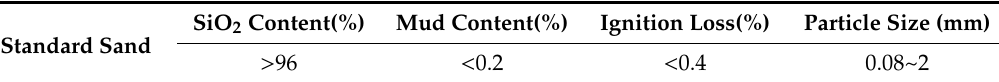
Table 3. Chemical composition and particle size of standard sand.